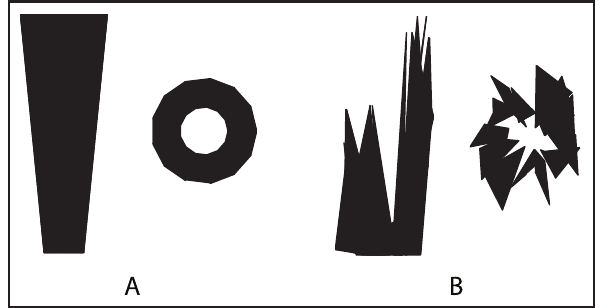
Figure 9. Constructing tussocks from a base model. A) Side and top view of the base model. B) Side and top view of randomly perturbed base model forming a tussock.